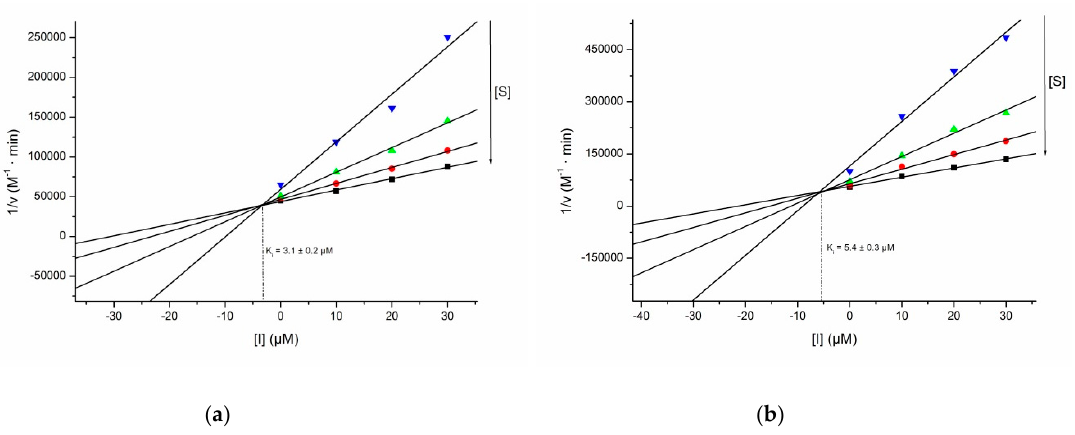
Figure 3. Dixon plots for the inhibition of AChE ( a ) and BChE ( b ) by compound 21 .